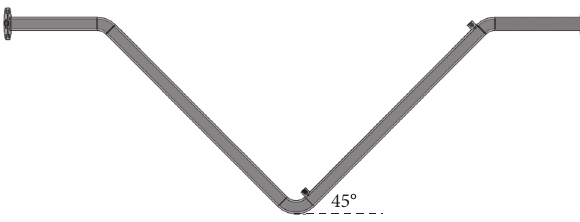
Figure 2: Schematic diagram of a hilly-terrain